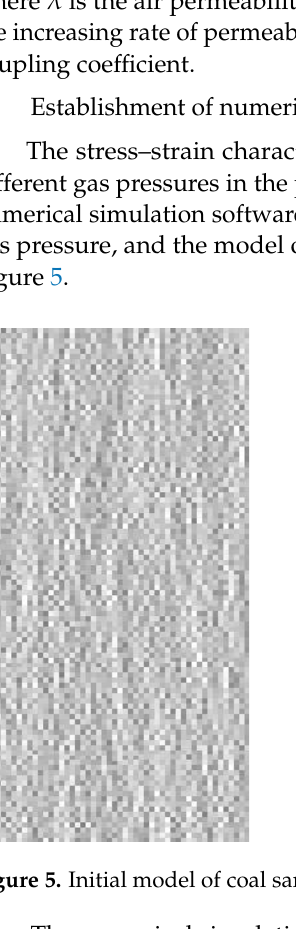
Figure 6. Problem analysis process of RFPA 2D gas plate software. The numerical simulation process, initial and boundary conditions of deformation, and failure of gas-containing coal are set according to the following methods [44 – 47]. A physical model of gas-containing coal samples was established, the size of which was 50 mm × 100 mm. The grid was divided into 90 × 180, the elastic modulus was set as 10,000 MPa, the strength was set as 100 MPa, the Poisson ’ s ratio was set as 0.25, the pres- sure ratio was set as 10, and the internal friction angle was set as 30. The horizontal and vertical permeability coefficients of the model were set as 0.1, the gas content coefficient was set as 3, the gas pressure coefficient was set as 1, the coupling coefficient was set as 0.2, and pore pressure coefficients were set as 0, 0.5, 1, 1.5, and 2. The loading process of the model specimen was displacement loading in the Y direction and free constraint in the X direction, and the loading rate was 0.005 mm/s. The loading steps of the model were set to 100. The SteplnStep option, confined water option, and dynamic problem option were selected. The seepage time was set to 24 h, and the osmotic pressure value was set to 2 MPa. The Shear and AE option was selected in the Custom Options Settings. The gas pressure option was selected and the gas pressure in the model is the same as the osmotic